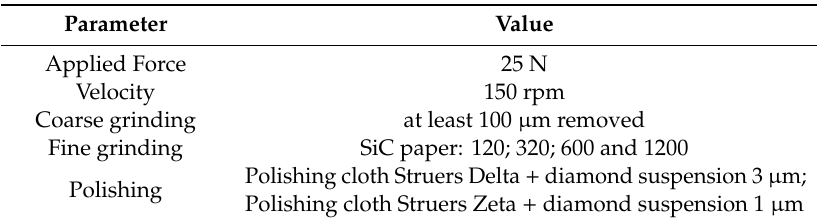
Table 2. Polishing Table 2. Polishing procedure.